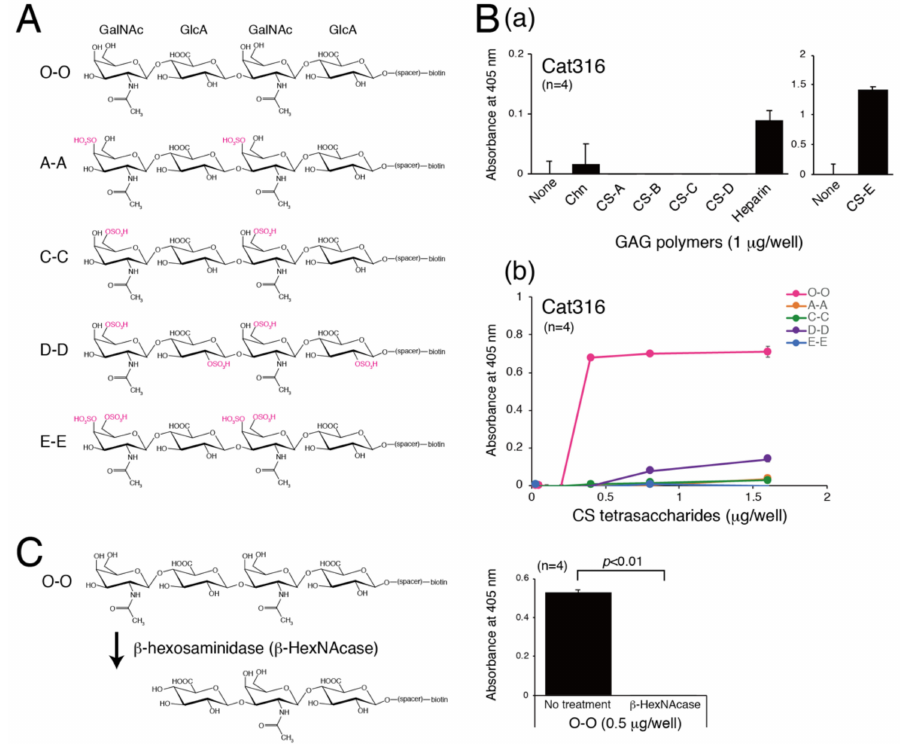
Figure 1. Cat316 specifically recognizes non-sulfated terminal GalNAc residues. ( A ) Structures of chemically synthesized biotinylated tetrasaccharides with various sulfations. ( B ) Biotinylated chondroitin (Chn) and GAG polymers (CS-A, CS-B, CS-C, CS-D, and heparin) ( a ) and chemically synthesized biotinylated tetrasaccharides (O-O, A-A, C-C, D-D, and E-E) ( b ) were immobilized onto a streptavidin-coated plate, and Cat316 was added to each well. Cat316 binding to immobilized GAGs or tetrasaccharides was measured by ELISA. ( C ), Cat316 binding to O-O tetrasaccharides digested with or without β -hexosaminidase ( β -HexNAcase) was examined. Statistical significance was determined using Student’s t